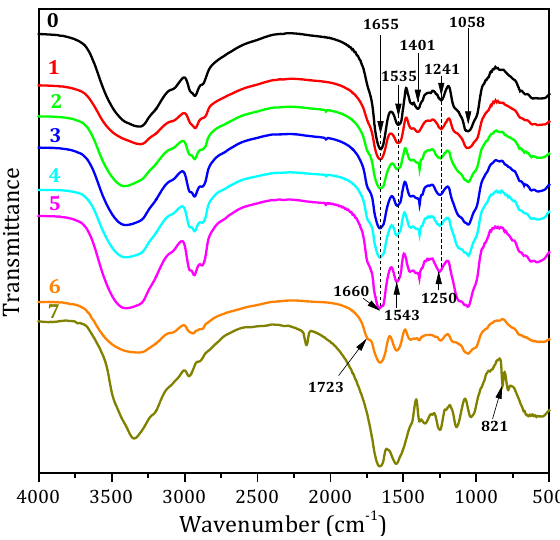
Figure 1. FTIR spectra of the different adhesives: 0 (SM adhesive), 1 (SM/SDS adhesive), 2 (SM/SDS/NGDE-2 adhesive), 3 (SM/SDS/NGDE-4 adhesive), 4 (SM/SDS/NGDE-6 adhesive), 5 (SM/SDS/NGDE-8 adhesive), 6 (SM/PAE adhesive), and 7 (MUF resin).